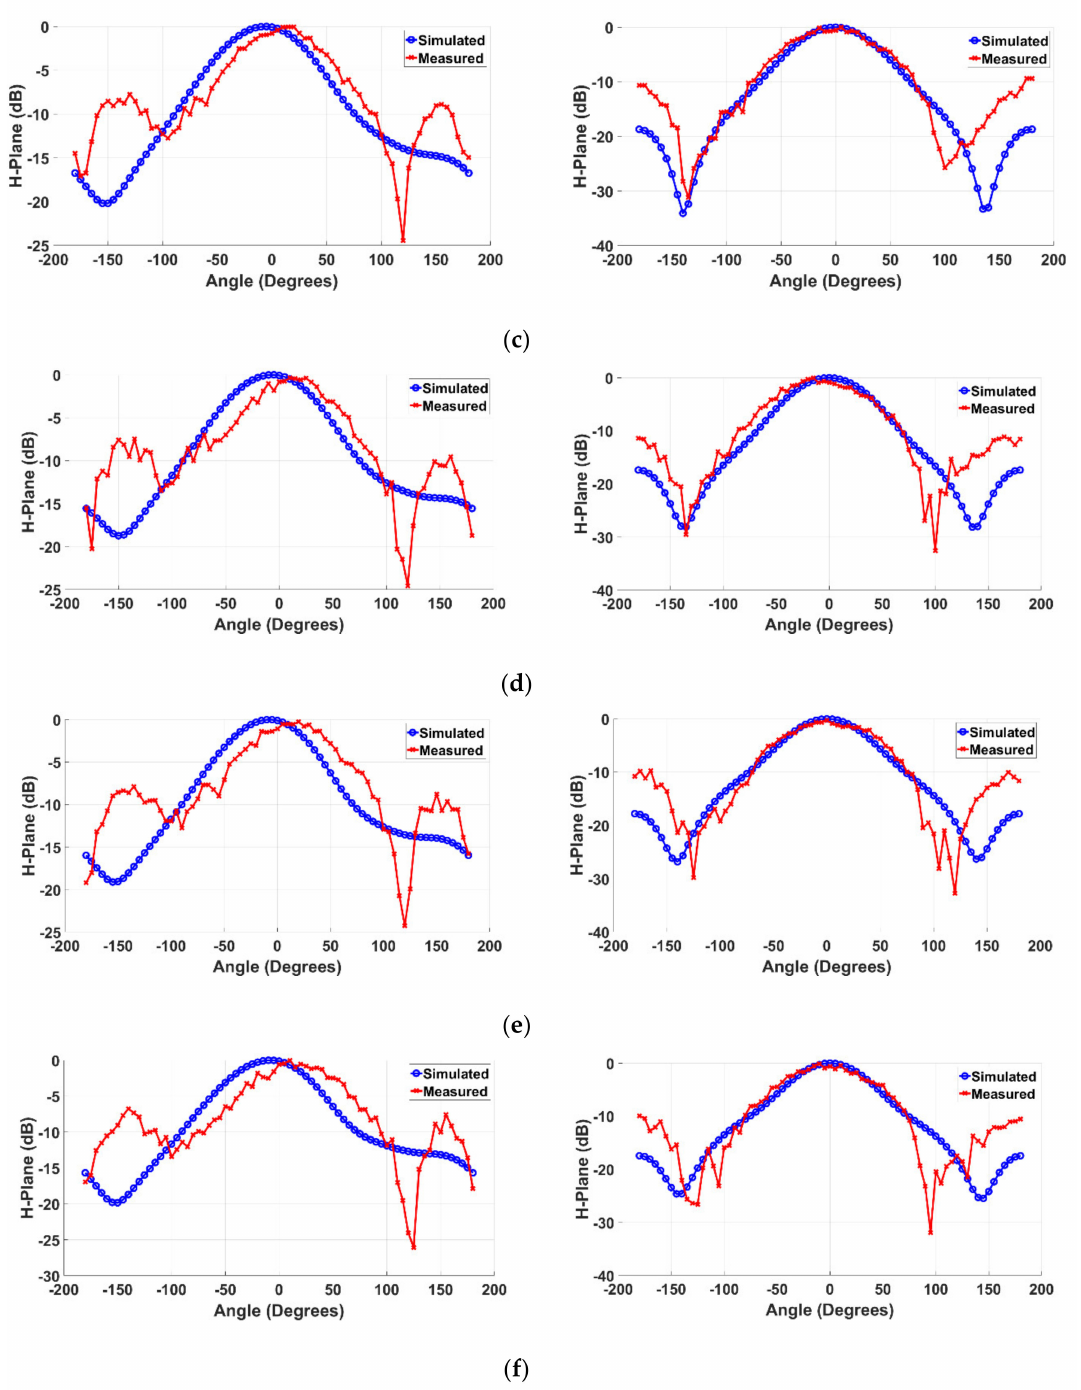
Figure 12. Simulated and measured normalized radiation patterns of the 3D-printed conformal antenna prototype in both the principal E- and H- planes at a resonance frequency of 2.4 GHz on ( a ) flat surface; ( b ) cylindrical surface of radius 88 mm; ( c ) cylindrical surface of radius 75 mm; ( d ) cylindrical surface of radius 60 mm; ( e ) cylindrical surface of radius 50 mm; and ( f ) cylindrical surface of radius 43